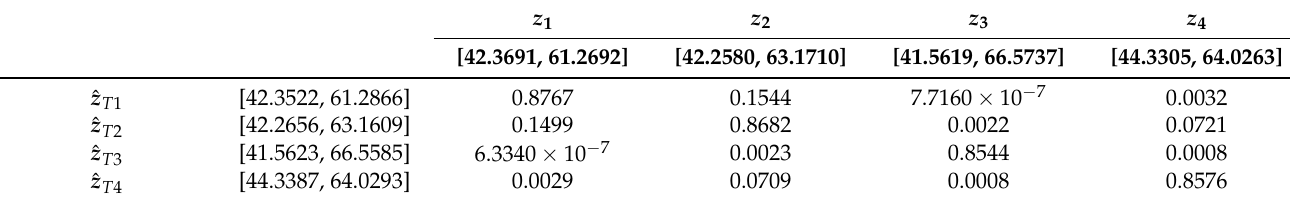
Table 3. Data association results when t k = 129.5 min.